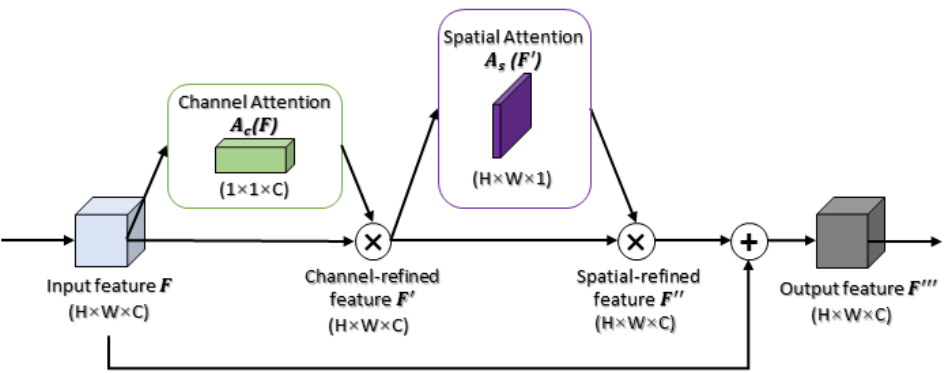
Figure 2. The structure of LRCA-Net.